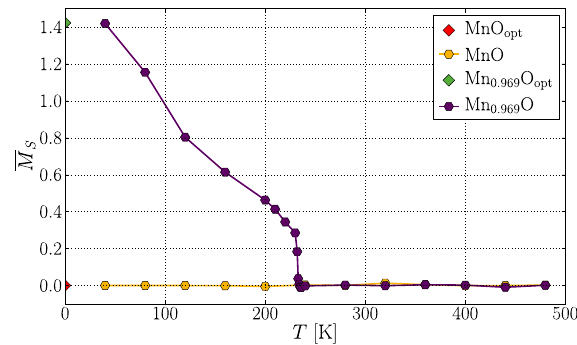
Fig. 7 Temperature dependence of the magnetization. Sum of the atomic spins per magnetic unit cell M S as a function of the temperature T obtained in optimizations and MDMC simulations for 6 × 6 × 6 supercells of MnO and Mn 0.969